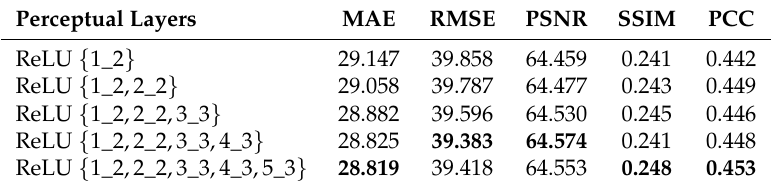
Table 8. Evaluation of variation in perceptual layers. The best scores are displayed in